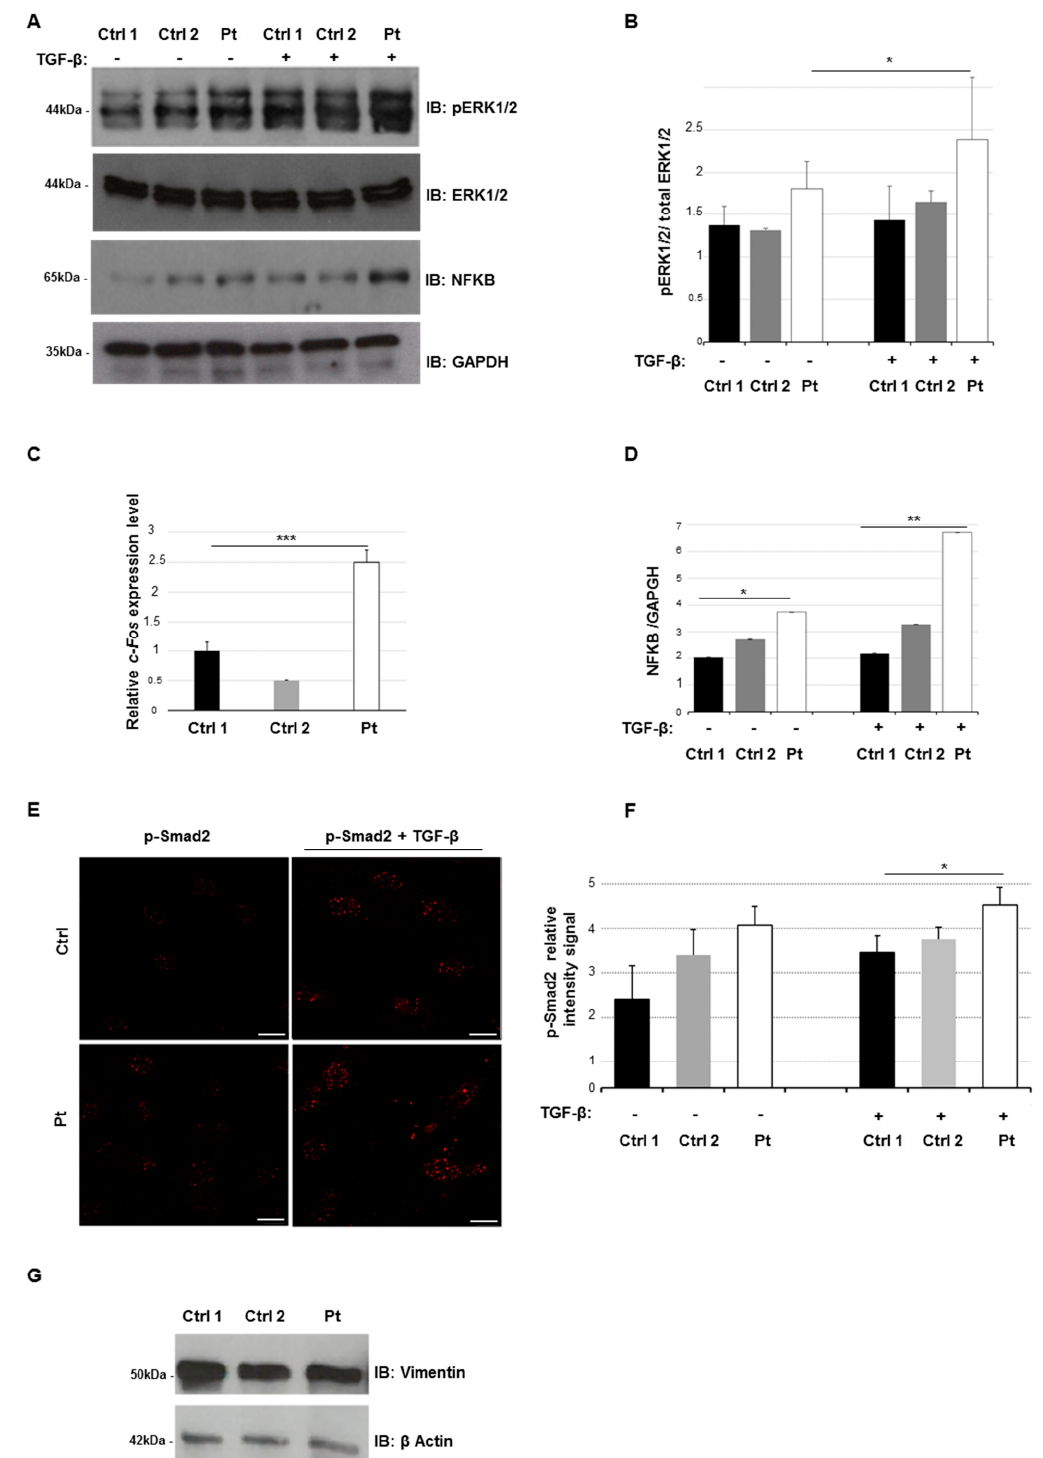
Figure 3. Transforming growth factor β (TGF- β ) non-canonical and canonical signaling anomalies. ( A ) Cell lysates were obtained from skin fibroblasts from patient (Pt) and controls (Ctrl) after stimulation with TGF- β (10 ng / mL) during 2 h in serum-free medium. Whole protein lysates were separated on 10% SDS-gel and subjected to immunoblotting with anti-ERK1 / 2 (extracellular signal-regulated kinase 1 / 2), anti p-ERK1 / 2, anti-NFKB (nuclear factor-kB) and anti-GAPDH Abs. ( B ) Levels of phospho–ERK1 / 2 were quantified by densitometry using IMAGEJ analysis software. Relative p-ERK1 / 2 levels were normalized compared to total ERK1 / 2 levels. GAPDH was used as internal control. Graphs show averages calculated on three di ff erent experiments, and scale bars represent standard errors. Values